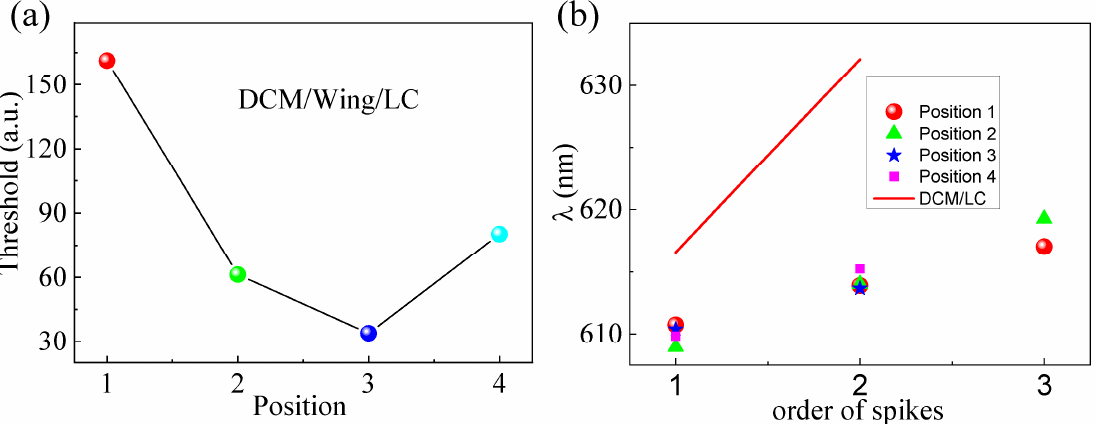
Figure 6. ( a ) Laser threshold of DCM/LC/Wing under different pumped positions, four colors represent four different pumped positions; ( b ) Peaks positions extracted from Figures 3a,b and 5a,b,c.